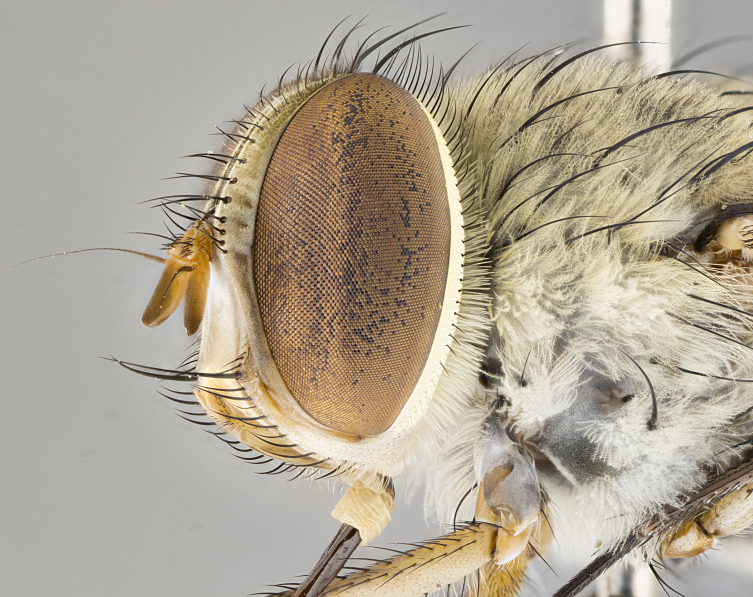
Detail of thorax and head of Telothyria
relicta van der Wulp, 1890 displaying the characteristic plumose hairs that cover the surfaces of the thorax. These hairs are unique to this genus, within the family Tachinidae.